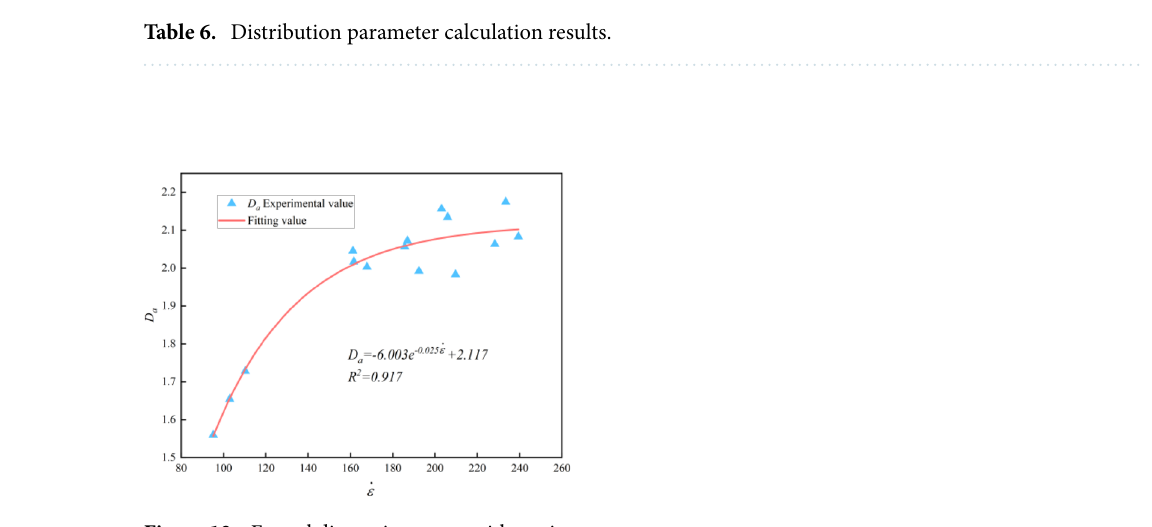
Figure 12. Fractal dimension curve with strain